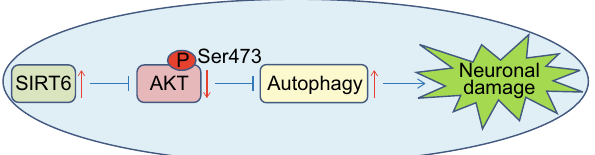
Figure 7. A schematic to summarize the role of SIRT6 in oxidative stress-induced neuronal damage. SIRT6 enhances neuronal cell death under oxidative stress via induction of autophagy mediated by attenuation of